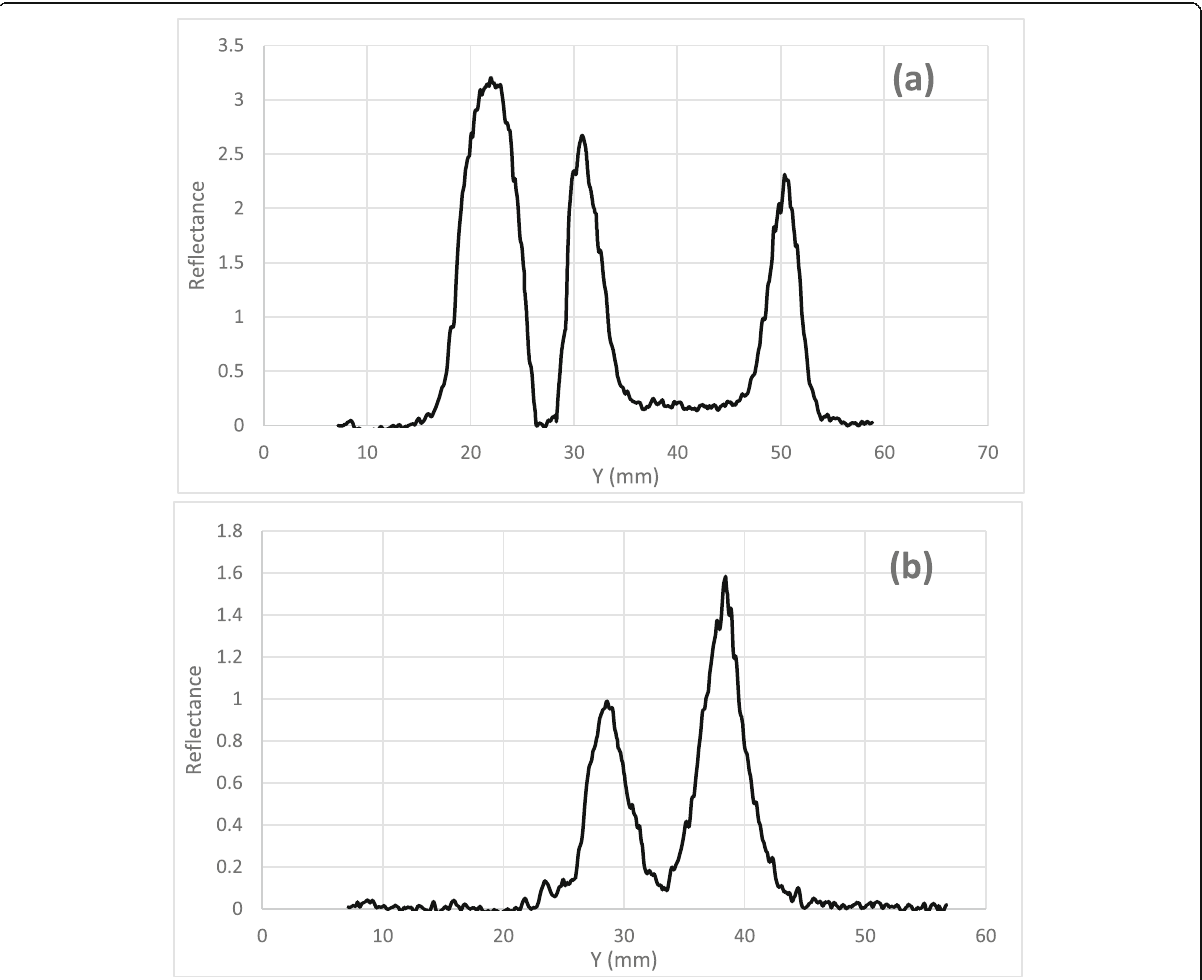
Fig. 6 Densitograms of the separated mixtures on SC-2P/Cu 2+ TLC plates. Spots mentioned from left to right as a p-, m-, and o-nitrophenol using n-hexane:DCE:n-propanol (75:20:5, v/v/v) as mobile phase system and b R( − )-, S(+)-ibuprofen using DCE:acetonitrile (90:10, v/v) as mobile phase